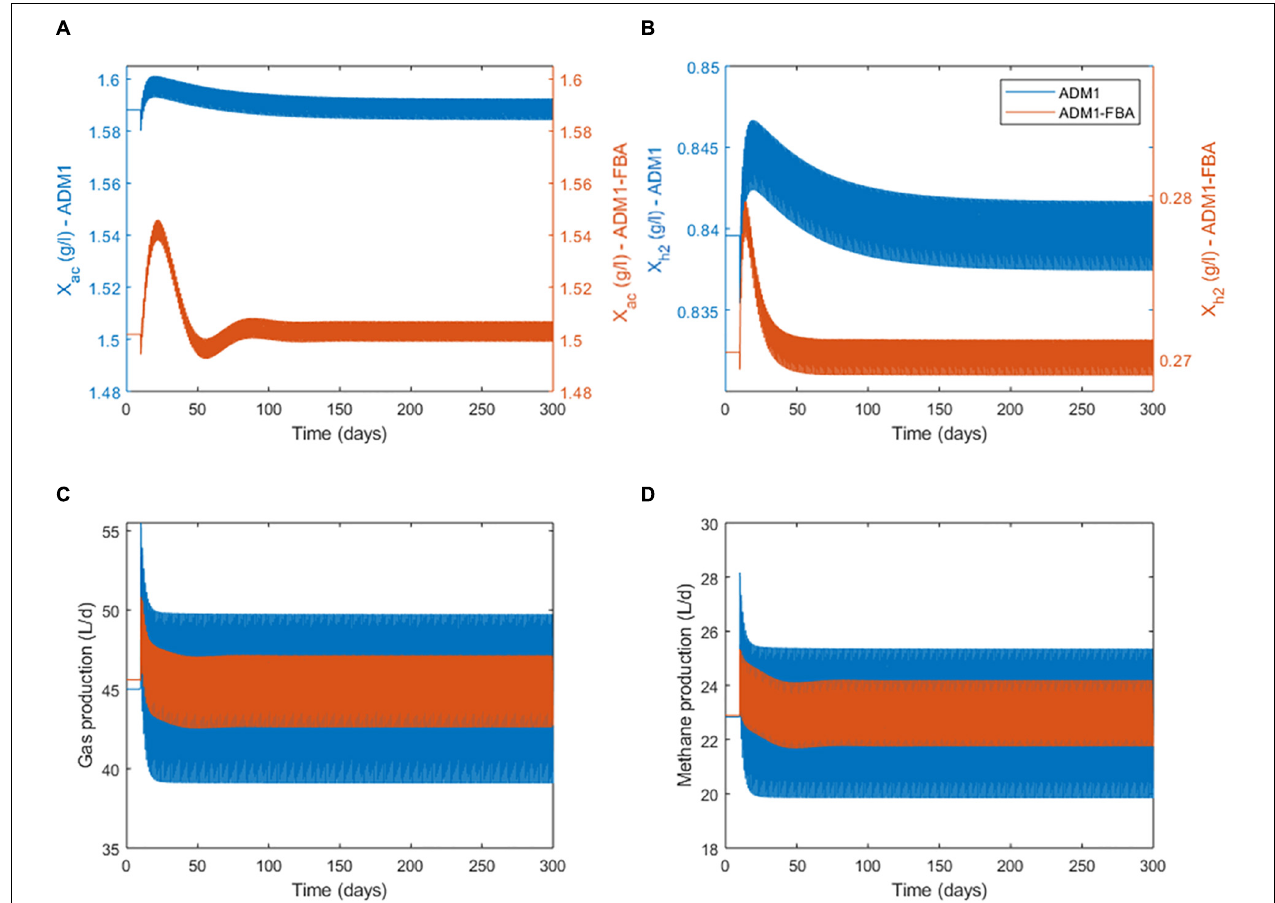
FIGURE 5 | Switching at day 10 from continuous feeding to a daily feeding pulse of 1 h providing the same amount of substrate and comparing standard ADM1 to the coupled model variant 8. Bands result from daily oscillations not resolvable here; see Figure 6 for daily dynamics. (A) Biomass concentration of the acetoclastic population. (B) Biomass concentration of the hydrogenotrophic population. Note the secondary y-axes scaling. (C) Process performance in terms of total gas production. (D) Process performance in terms of methane